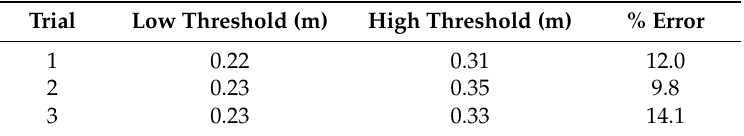
Figure 11. ( a ) Measured tether distance for the three walk trials (signals green, orange and blue for walk trial 1,2 and 3 respectfully). The dashed line represents the experimental tether distance (30 cm). The brackets indicate the effect of AP walking on the calculated tether distance, observed as sinusoidal waves. ( b ) Wheelchair direction commands for the three walk trials. Table 3. The low and high thresholds and the wheelchair direction command errors produced by the drive control for each trial.